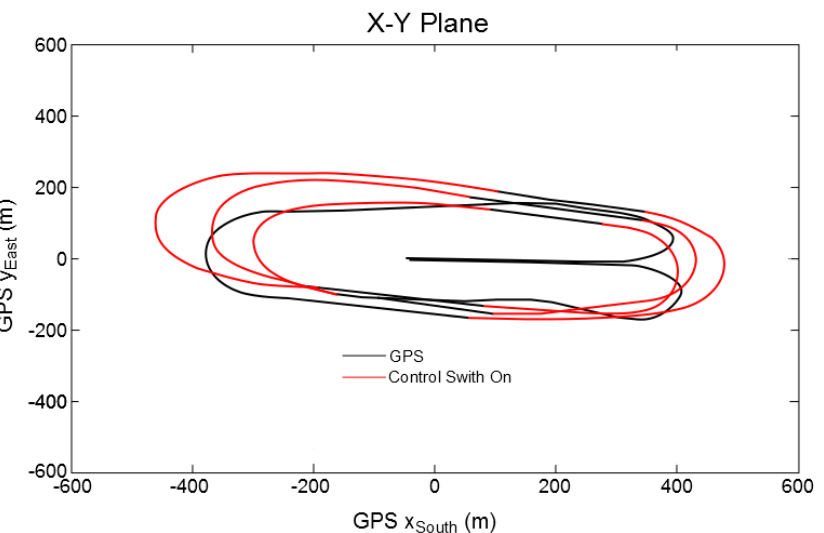
Figure 2. GPS trajectory of a typical flight, flight path highlighted with red corresponds to control switch in the on